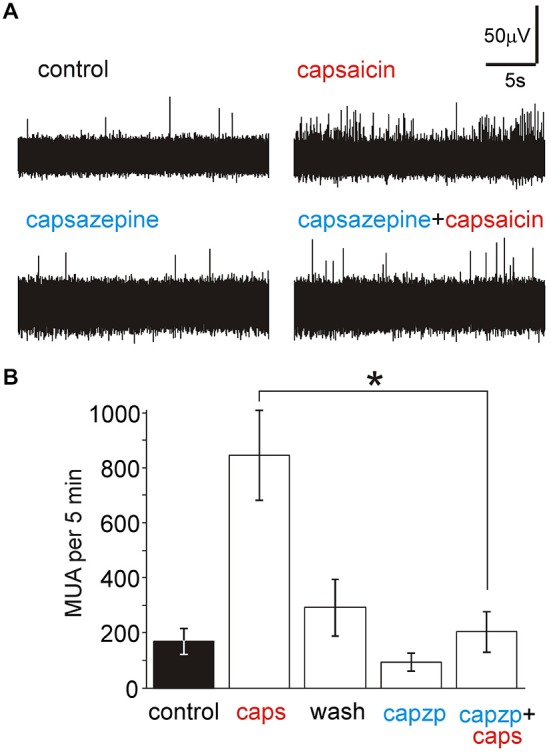
Capsazepine prevents the activation of nociceptive firing by capsaicin in
nervus spinosus.
(A) Example traces of the multiple unit activity stimulated by 1 μM capsaicin in control (top) and in the presence of 50 μM capsazepine (bottom). (B) Histograms showing the average effect of 1 μM capsaicin (n = 10), washout of the agonist (n = 10), effect of 50 μM capsazepine (n = 5) and action of 1 μM capsaicin in the presence of 50 μM capsazepine (n = 5) on the number of nociceptive spikes during 5 min of recordings. *p < 0.05.